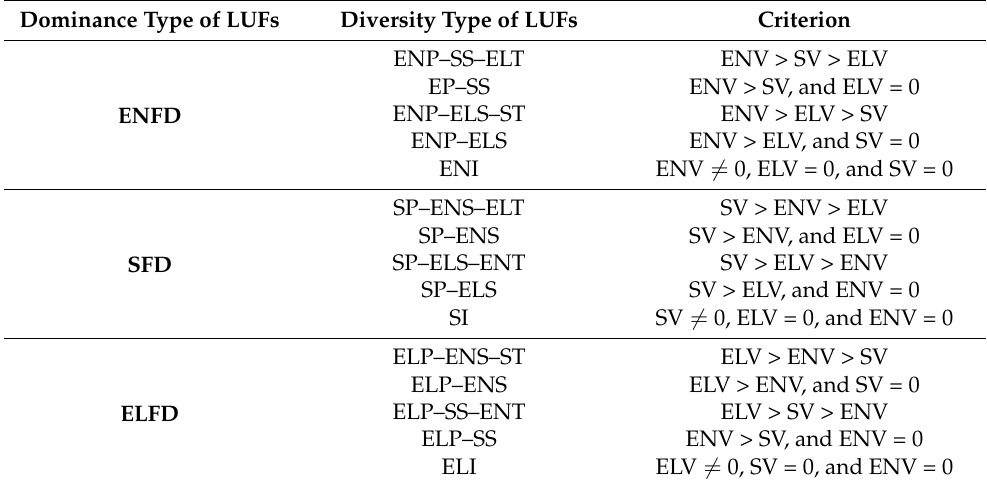
Table 1. Discriminant basis for diversity and dominance types of LUFs.